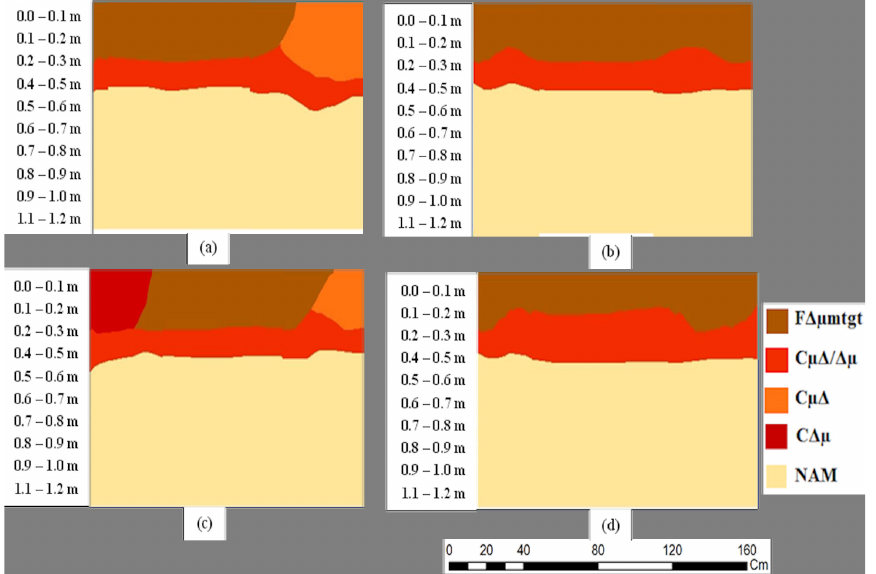
Figure 1. Cultural profiles of a dystrophic Red- Yellow Latosol under conventional tillage